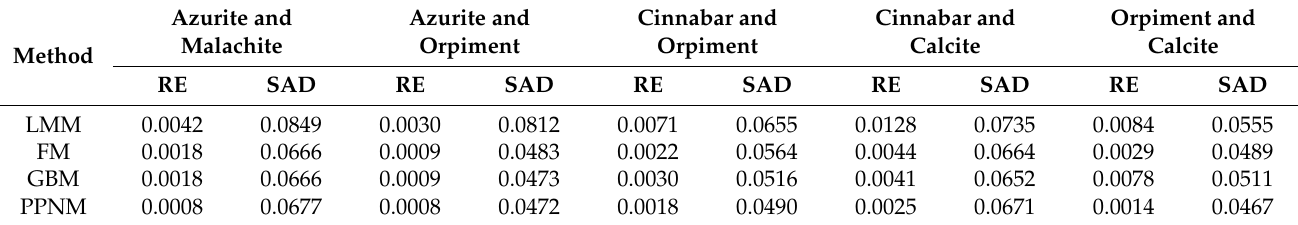
Table 8. The mean RE and mean SAD for mixed pigment samples of linear and nonlinear mixing models.